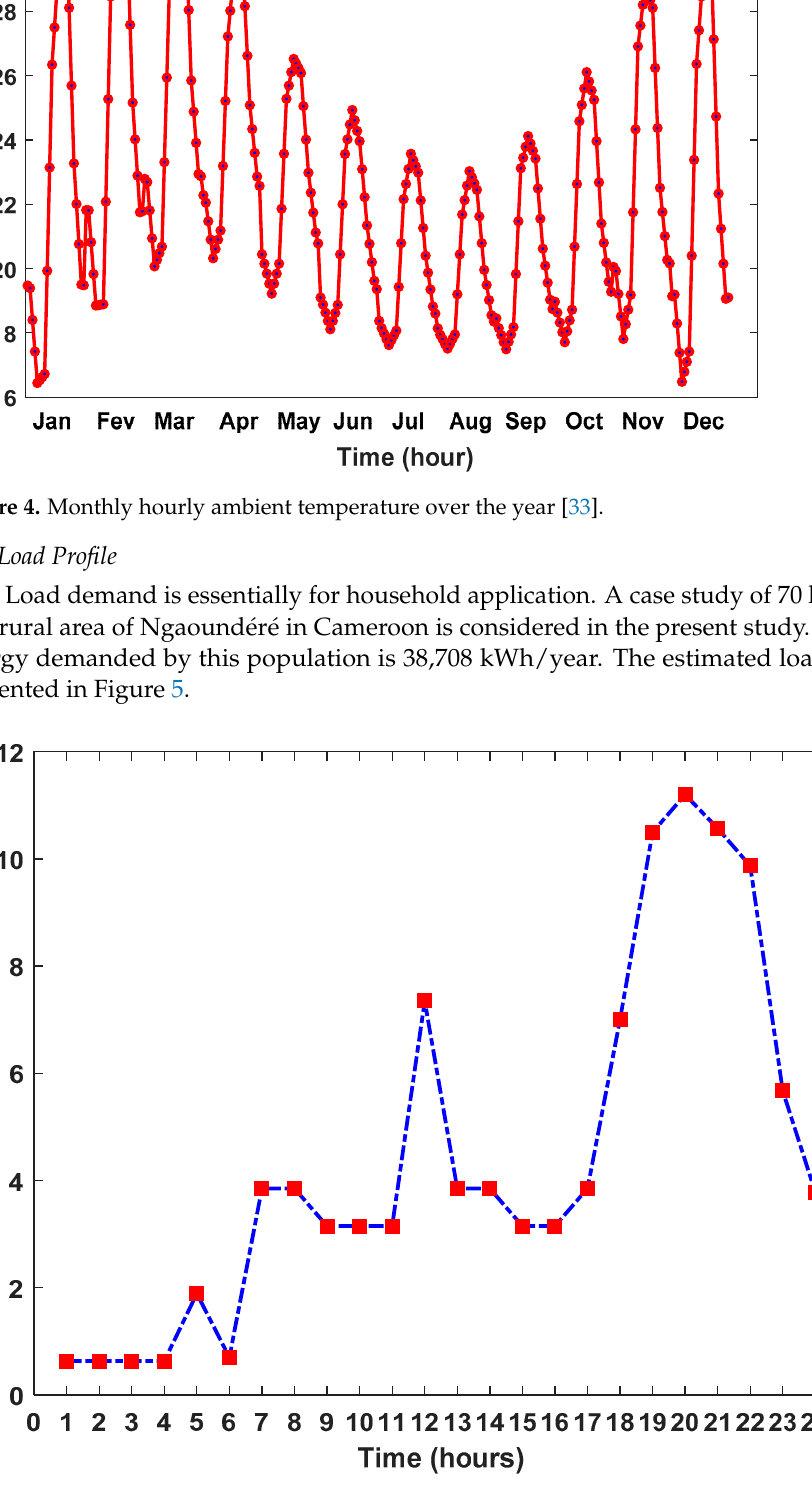
Figure 5. The daily profile of the load demand.